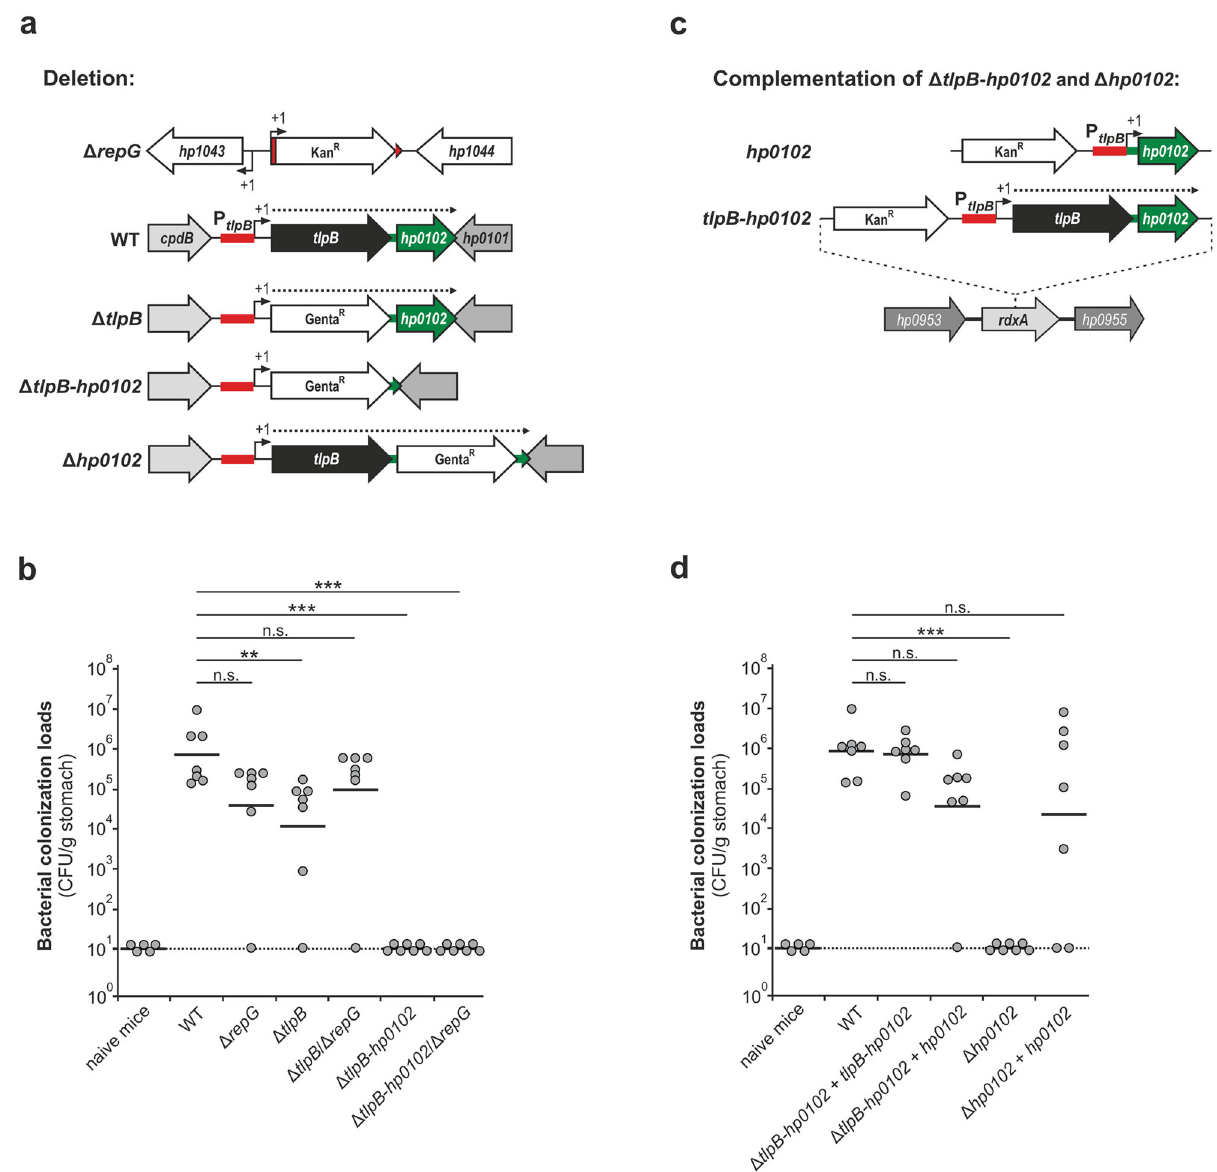
Fig. 3 HP0102 is essential for mice stomach colonization with H. pylori strain X47-2AL. a , c Schematic representation of the construction of H. pylori X47-2AL Δ repG and Δ tlpB/hp0102 deletion mutant and complementation strains. TSS are denoted as + 1 (black arrows). The repG gene and the tlpB promoter (P tlpB ) are shown in red. The hp0102 gene is shown in green. b , d About 10 8 bacteria of H. pylori X47-2AL WT or indicated mutant strains were orogastrically administered to NMRI Swiss mice. As a control, mice were infected with peptone broth only. Four weeks post infection, mice were sacri fi ced and colony-forming units (CFUs) per gram of stomach weight were calculated by serial dilutions and plating assays. Each circle indicates the colonization titer in the stomach of a single mouse. The horizontal bars represent the geometric mean for each group of data ( n = 5/4 non-infected control animals for panel b/d, respectively; n = 7 for mice infected with indicated H. pylori strains). *** — highly signi fi cant, p -value < 0.001; ** — very signi fi cant, p -value <